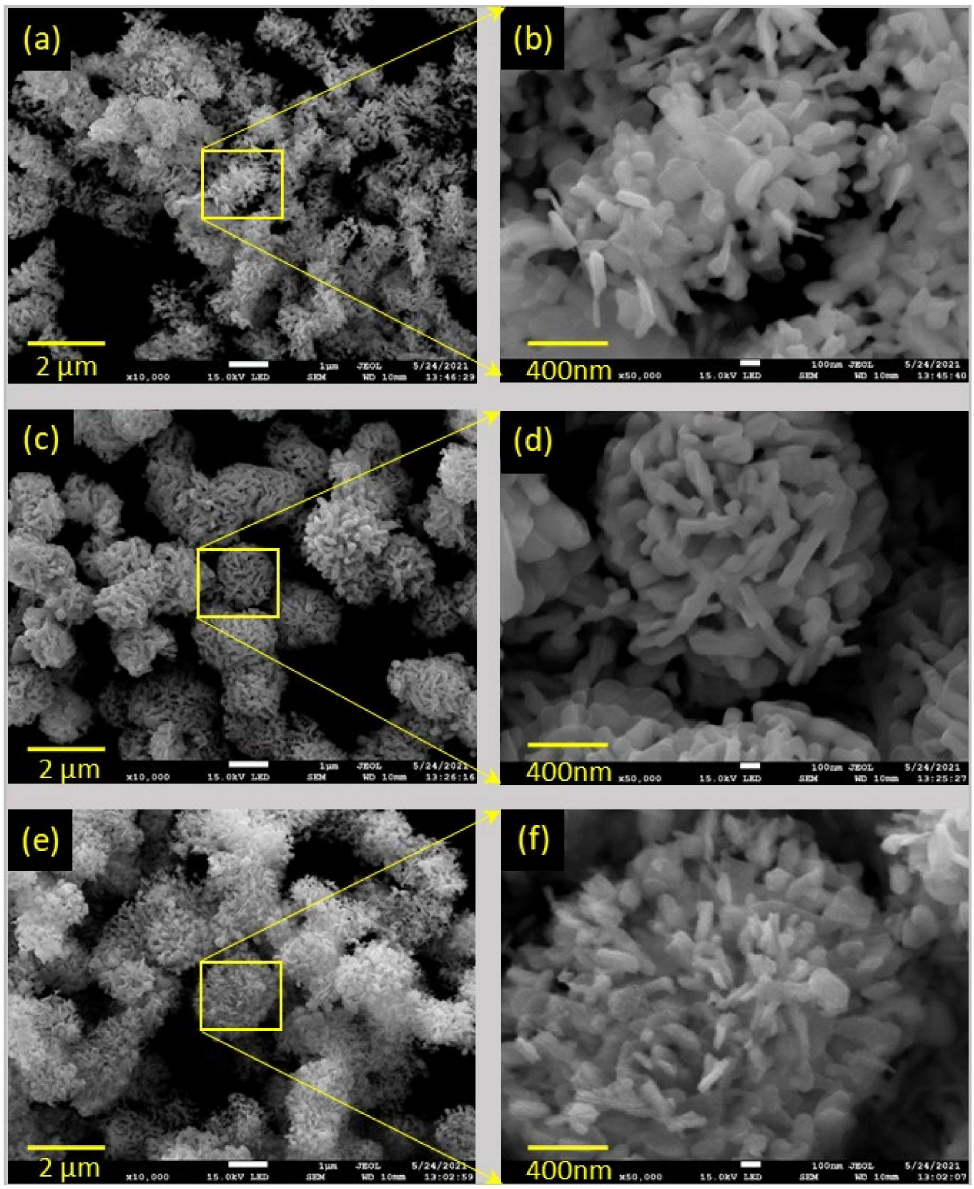
Figure 2. FESEM images of ( a , b ) BOC, ( c , d ) BOI, and ( e , f ) BOC/BOI-3 heterostructures. The microstructure of the BOC/BOI heterojunction was investigated using